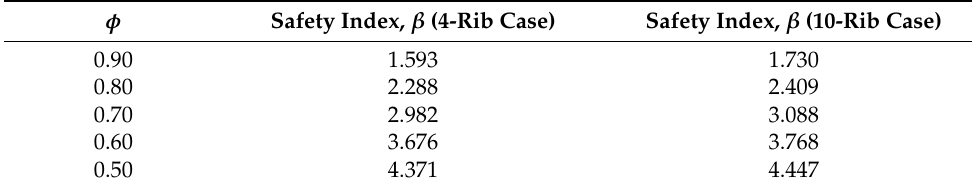
Table 23. Shear resistance reduction factors and safety index